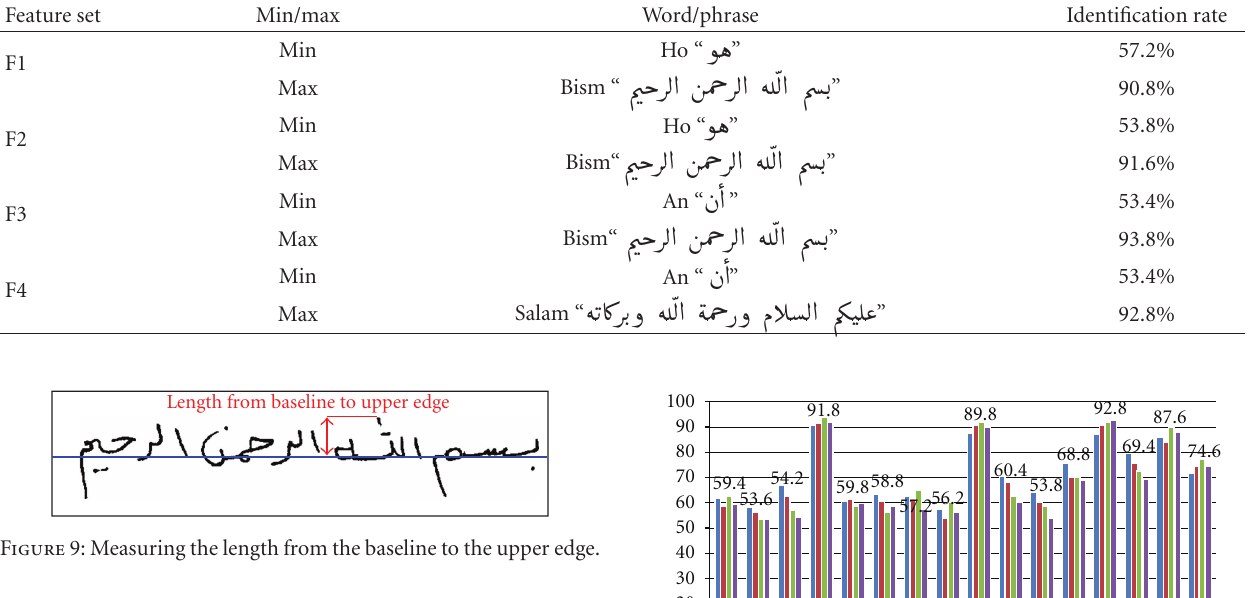
Table 3: Identification rates for di ff erent sets of features: F1, F2, F3, and F4.